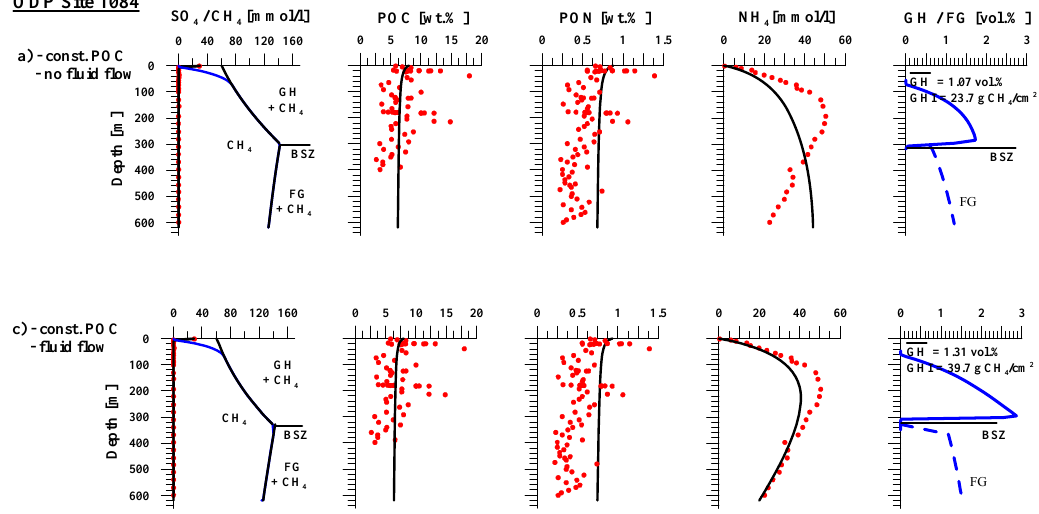
Fig. 7. Model results for ODP Site 1084 off Namibia for two different model runs: (a) constant POC input, and (c) constant POC input combined with advective fluid flow. Figure 7. Model results for ODP Site 1084 off Namibia for two different model runs: a) Table 2. Input parameters and boundary conditions for the standard model using average values of all specific ODP models. The range of parameter values used for the sensitivity analysis are also shown. constant POC input, and c) constant POC input combined with advective fluid flow. Standard model Sensitivity (average of ODP